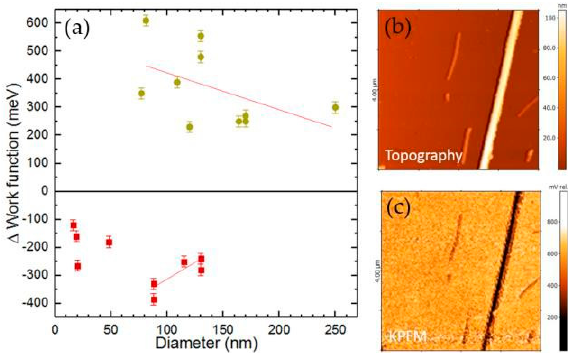
Figure 2. ( a ) Difference in WF between SnO 2 NWs and the Cr substrate (dark yellow circles), and CuO NWs and Cr (red squares). Red lines are linear fits to the data points; ( b ) Topography and ( c ) KPFM image (4 × 4 µm 2 ) of a representative CuO